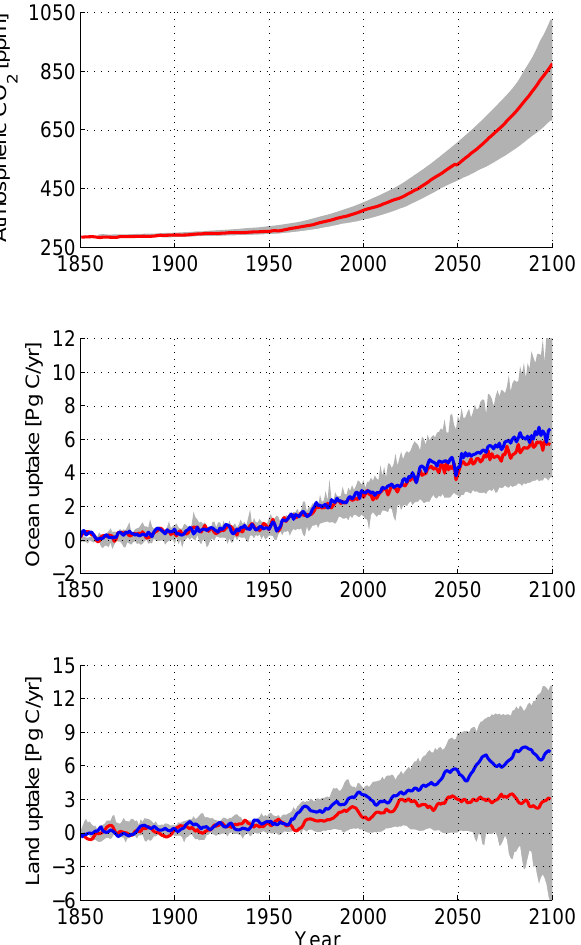
Fig. 3. BCM-C projection of annual (top) atmospheric CO 2 con- centration, (middle) oceanic carbon uptake and (bottom) terrestrial carbon uptake as compared to the range from other models (grey shading) (Friedlingstein et al., 2006). Red lines represent results from COU whereas blue lines represent results from UNC simula- tions.